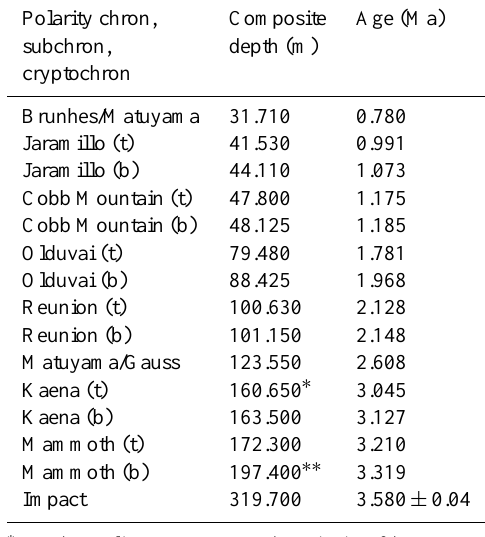
Table 4. Magnetostratigraphic tie points, their depth in the com- posite record from Site 5011-1 and their age (Ma) from LR04, ex- cept for the ages of the Cobb Mountain and Réunion cryptochrons, which are from Ogg and Smith (2004). Ages for the Intra-Jaramillo and Olduvai precursor events are derived from tuning with respect to the LR04 stack (Nowaczyk et al.,